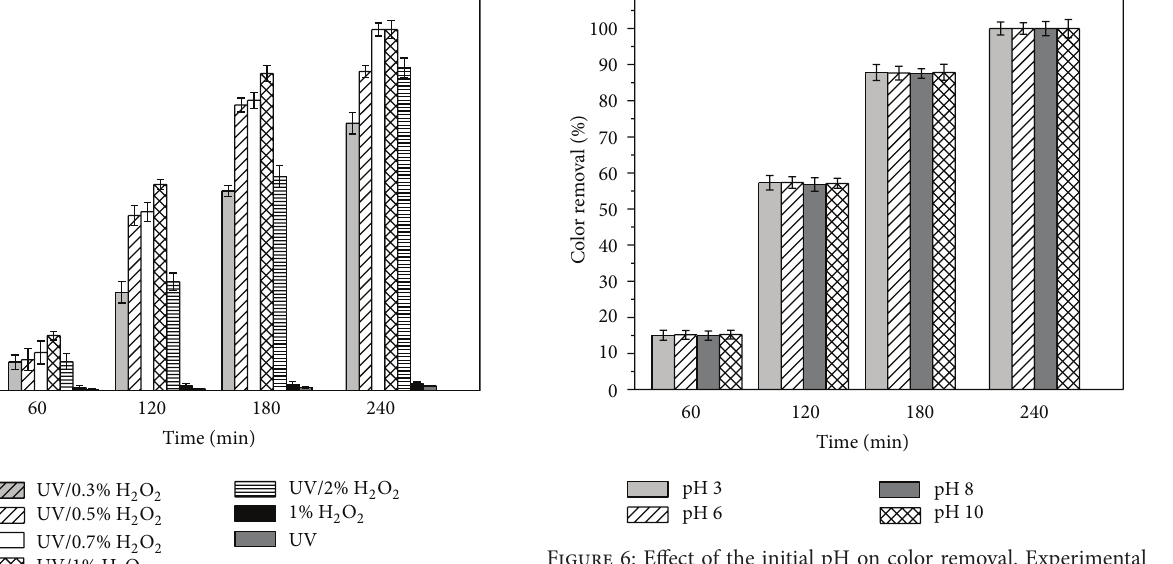
Figure 6: Effect of the initial pH on color removal. Experimental conditions: UV/1% H 2 O 2 and 25 ∘